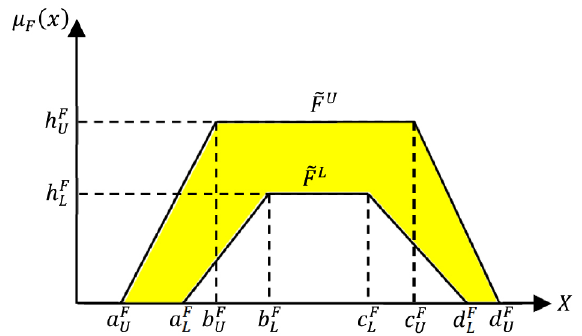
Figure 1. Trapezoidal IT2FS